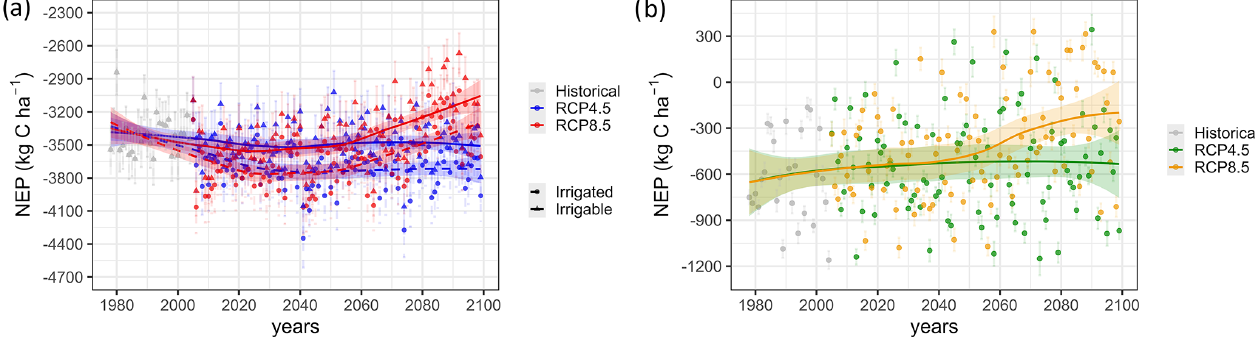
Figure 10. Net ecosystem production (NEP; kgCha − 1 ) for croplands (a) and grasslands (b) , with two climate change scenarios (RCP4.5 and RCP8.5). Croplands reported two irrigation conditions following the irrigable agricultural area in Europe or extending the irrigation to all the arable lands (scenarios i_RCP4.5 and